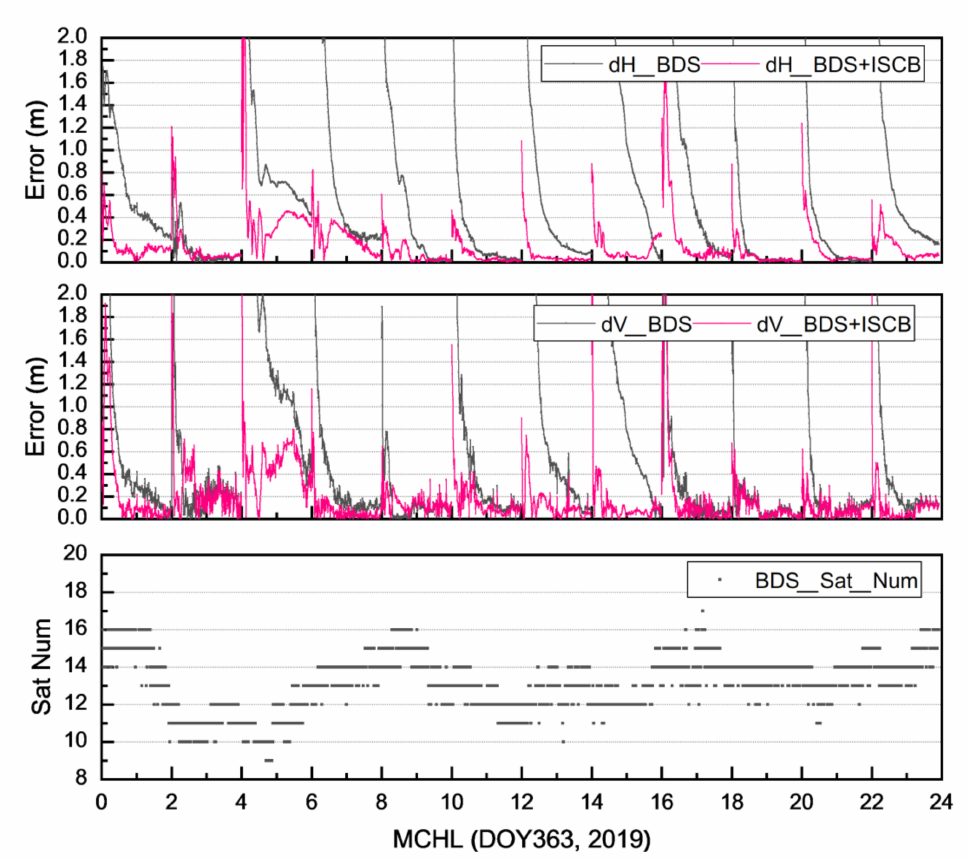
Figure 8. A comparison of the horizontal and vertical convergence of BDS, 2+3 joint PPP with and without ISCB self, calibration of MCHL on day of year (DOY) 363 of